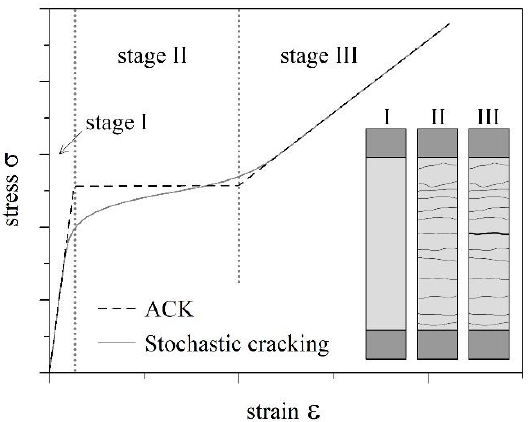
Figure 14. Typical stages of the tensile response in the ACK and Stochastic cracking models and illustrative cracking patterns.